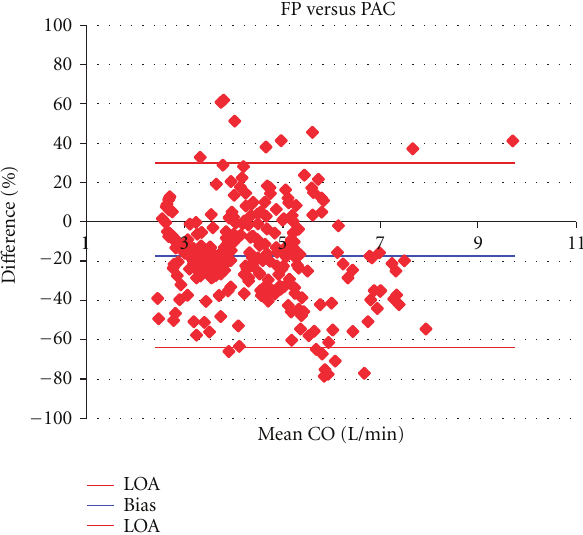
Figure 2: Bland Altman plots of FP versus PAC showing bias ( − 17.2%) and LOAs ( − 64.2% and 29.8%).